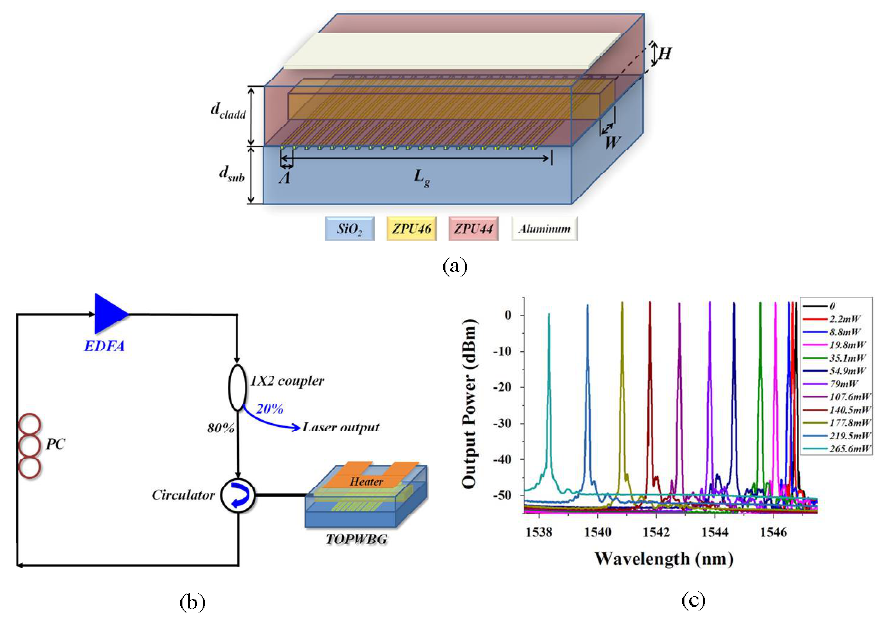
Figure 18. ( a ) The structure of the TOPWG; ( b ) the schematic of the proposed tunable fiber ring laser with TOPWBG as the wavelength selective filter; and ( c ) the output spectra of the tunable fiber ring laser with different heating power [67]. Copyright 2015 Elsevier.